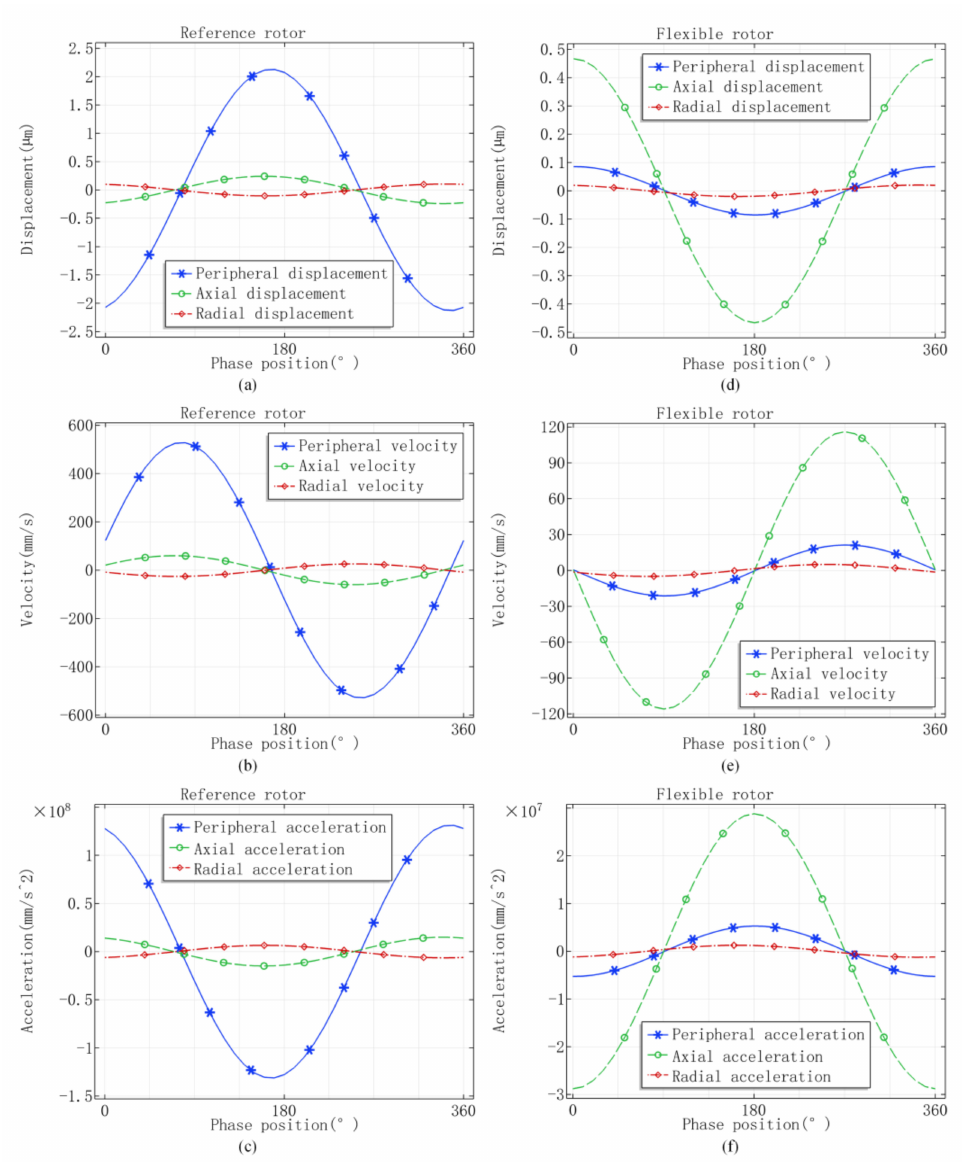
Figure 8. Modal response of reference rotor and flexible rotor within one oscillatory period. ( a ) Peri- odical displacement response of reference rotor. ( b ) Periodical velocity response of reference rotor. ( c ) Periodical acceleration response of reference rotor. ( d ) Periodical displacement response of flex- ible rotor. ( e ) Periodical velocity response of flexible rotor. ( f ) Periodical acceleration response of flexible